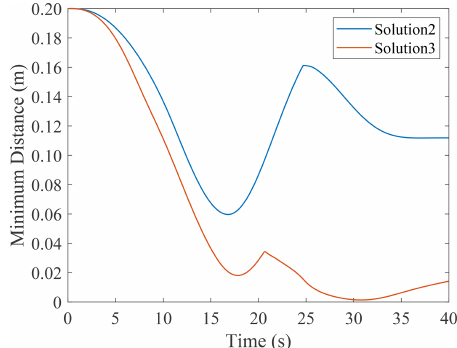
Figure 7. Pareto front.